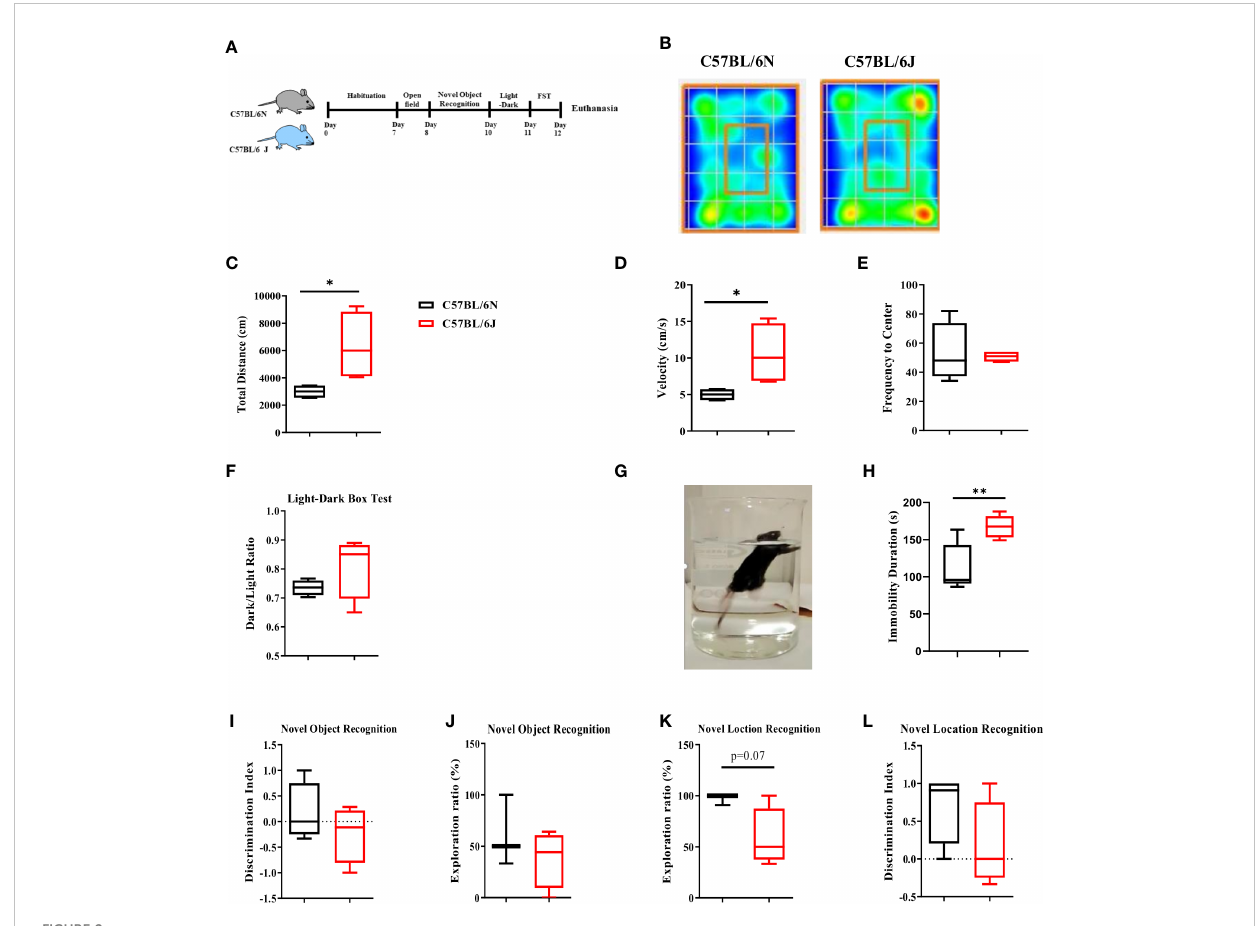
FIGURE 2 Affective and cognitive behavior in C57BL/6 sub-strains. (A) Experimental design set 1. Naïve adult C57BL/6N and C57BL/6J mice were assessed for affective and cognitive behavior using a battery of tests that started with the least to the most stressful ones. (B) Heat map of the sub-strains movement pattern in open fi eld test under steady state. (C) Total distance travelled, (D) Velocity, and (E) frequency to the centre were measured. (F) Dark-to-light transition ratio using light-dark box test. (G) Depression-like behavior was assessed using FST (H) and total immobility time was determined using EthoVision ® XT 8. (I) Exploration ratio and (J) Discrimination index in NOR test. (K) Exploration ratio and (L) Discrimination index in OLT test. Results are representative of two independent experiments with 4 – 7 mice/group. Data are expressed as mean ± S.E.M. *P < 0.05, **P < 0.001 by two-tailed unpaired Student